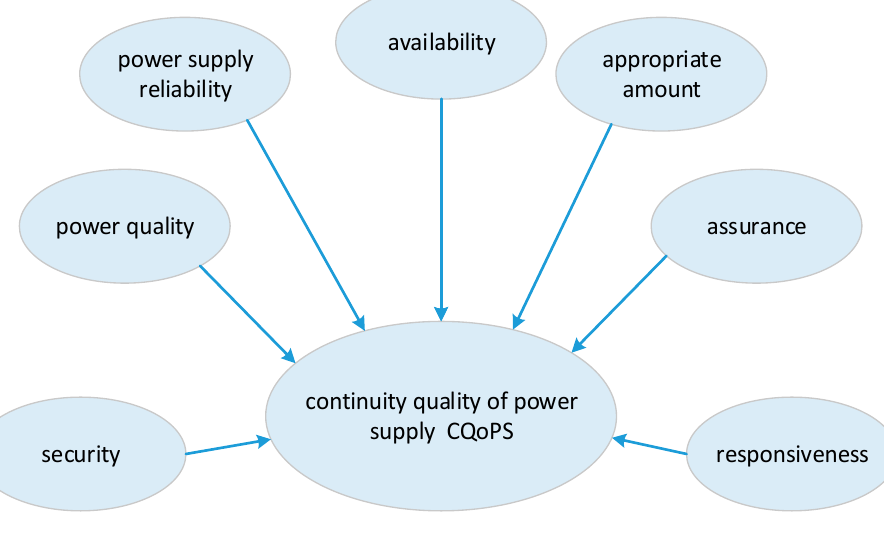
Figure 2. CQoPS dimensions.